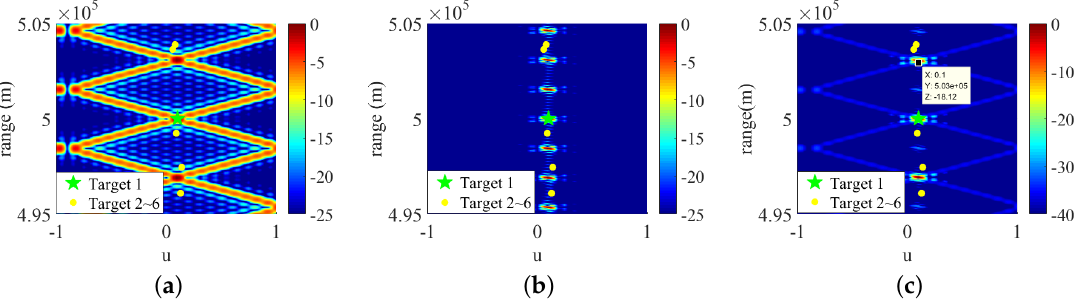
Figure 3. ( a ) Transmit, ( b ) receive and ( c ) overall T-R beampatterns with selected frequency increment.